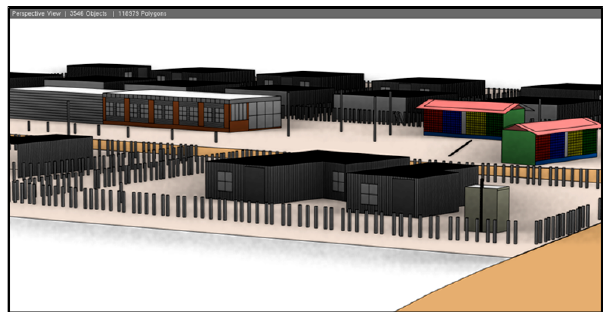
Figure 1. A section of the Slovo Park informal settlement modelled at LoD3. Source: Rautenbach et al.